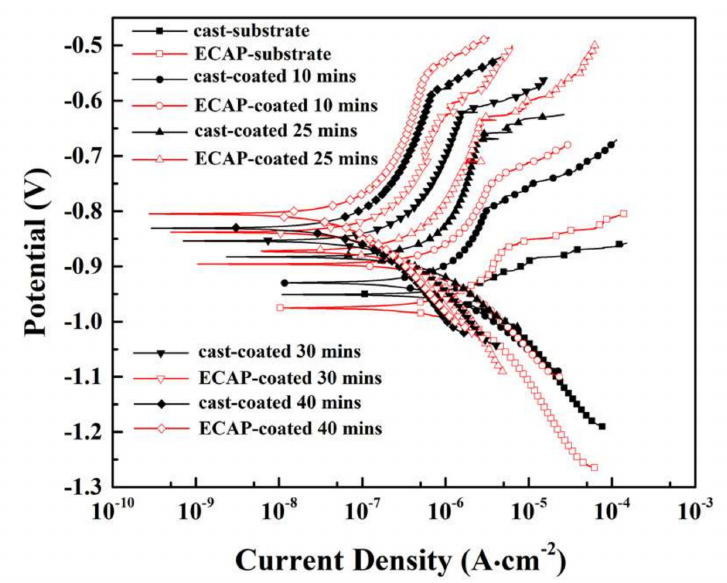
Figure 6. Potential dynamic polarization curves of the coated and substrate samples in NaCl